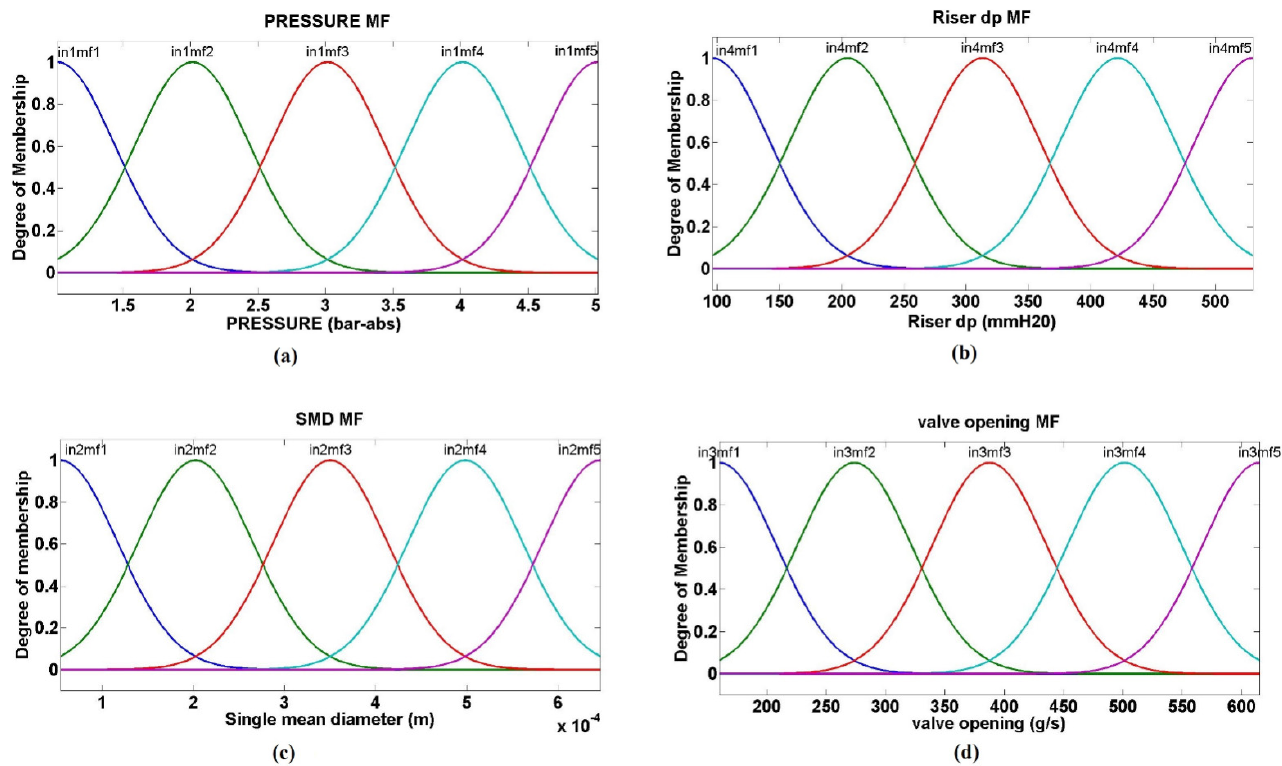
Figure 9. Trained MFs of the input variables, ( a ) trained Gaussian MFs of pressure, ( b ) trained Gaussian MFs of riser dp, ( c ) trained Gaussian MFs of single mean diameter, ( d ) trained Gaussian MFs of total valve opening.